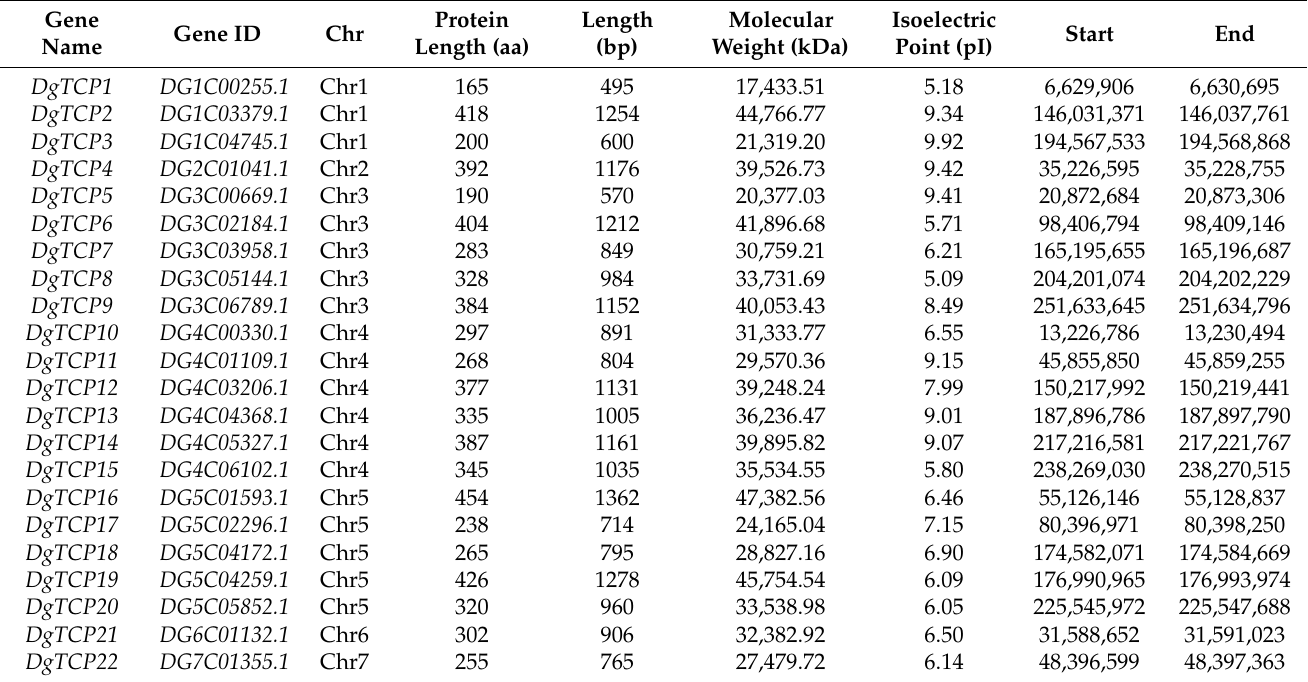
Table 1. The 22 TCP genes in